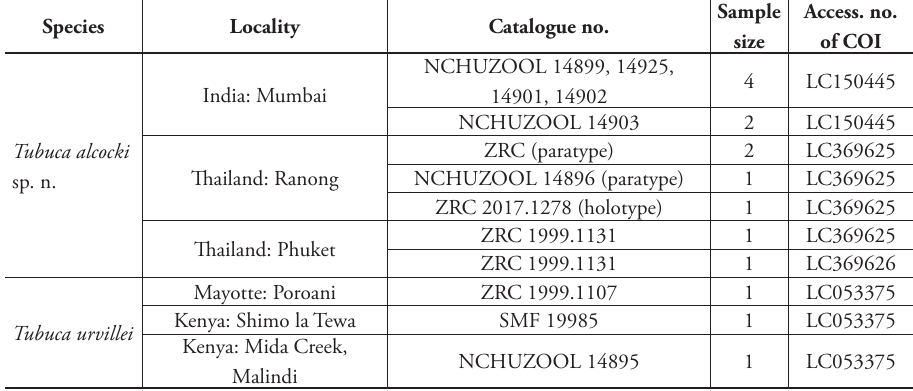
Table 1. The haplotypes of COI gene of Tubuca alcocki sp. n. and T. urvillei from the Indian Ocean. Ab- breviations of museums or universities see Material and